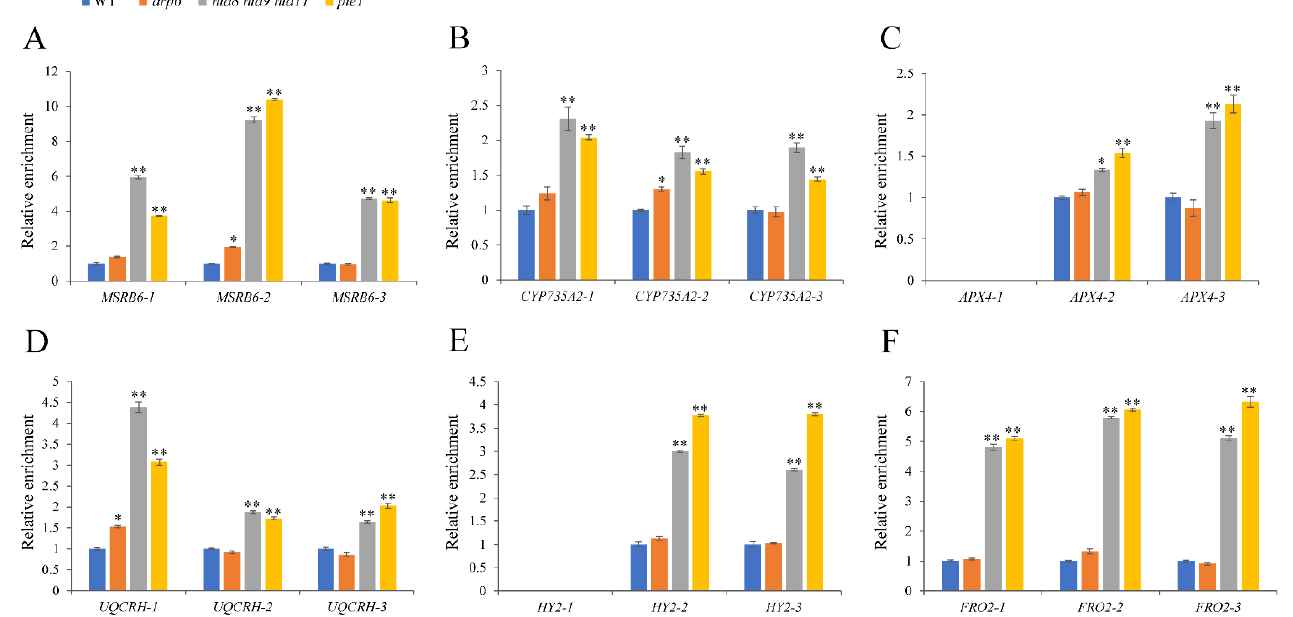
Figure 8. H3K27me3 enrichment in oxidoreductase activity-related genes was altered in arp6 , hta8 hta9 hta11 , and pie1 roots: (A– F ) ChIP-qPCR analysis of H3K27me3 enrichment in MSRB6 , CYP735A2 , APX4 , UQCRH , HY2 , and FRO2 genes in WT, arp6 , hta8 hta9 hta11 , and pie1 roots. Primer set numbers are the same as those listed in Figure 5. Error bars indicate ± SD ( n = 3 replicates). Asterisks above the columns indicate statistically significant differences (* p < 0.05, ** p < 0.01) determined by Student’s t